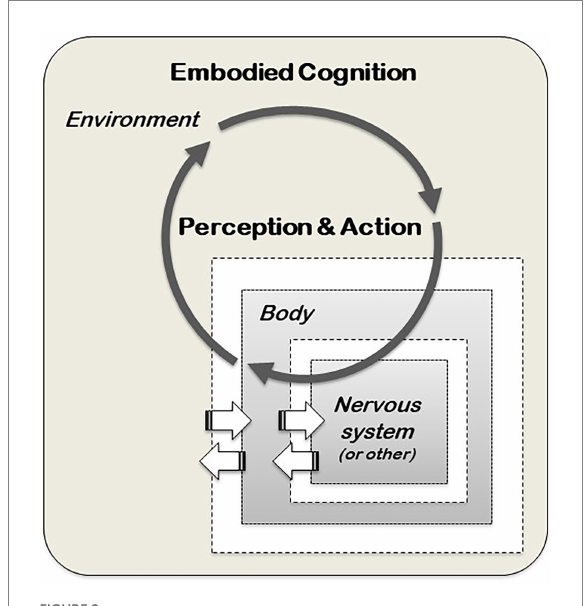
FIGURE 2 A post-cognitivist model of cognition. Within this model, the brain and nervous system (or other internal systems, such as the vascular system in plants) are embodied in the biological body of the organism, the body is situated in a local environment and behaviour is not a property of the organism, but an emergent property of the interacting dynamical system of nervous system- body-environment (adapted from Beer,